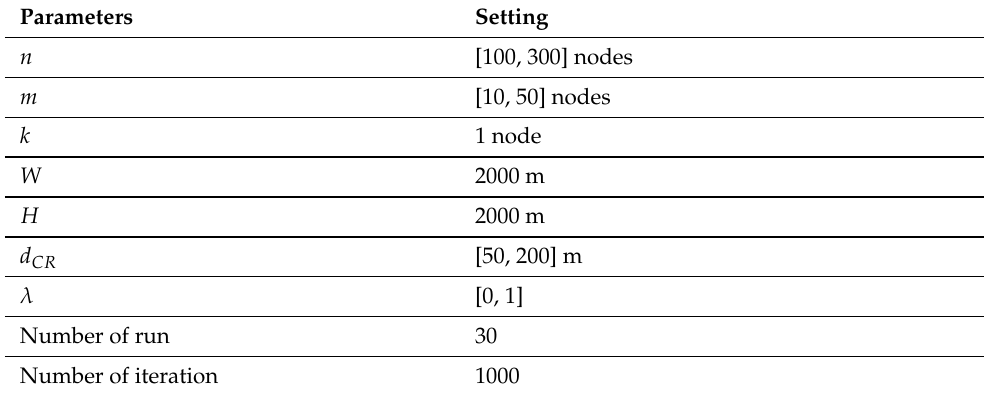
Table 4. Simulation parameters.